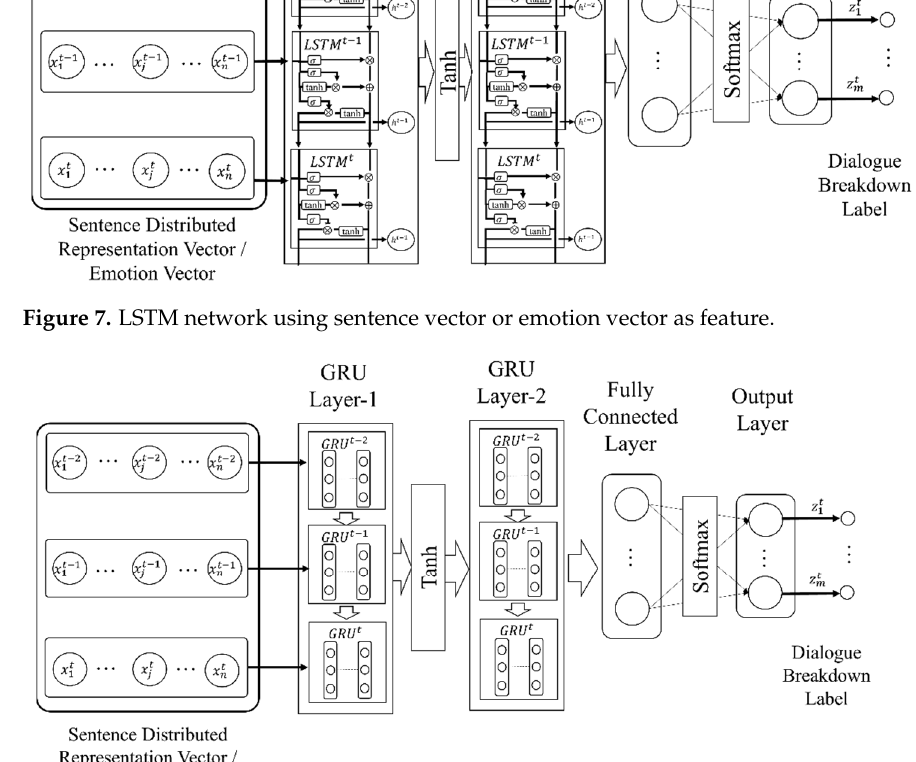
Figure 8. GRU network using sentence vector or emotion vector as feature.